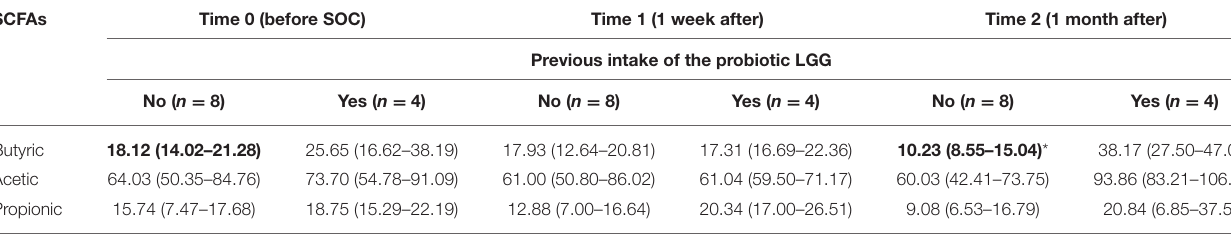
TABLE 2 | Concentrations of main SCFAs over time in the fecal samples of the study.